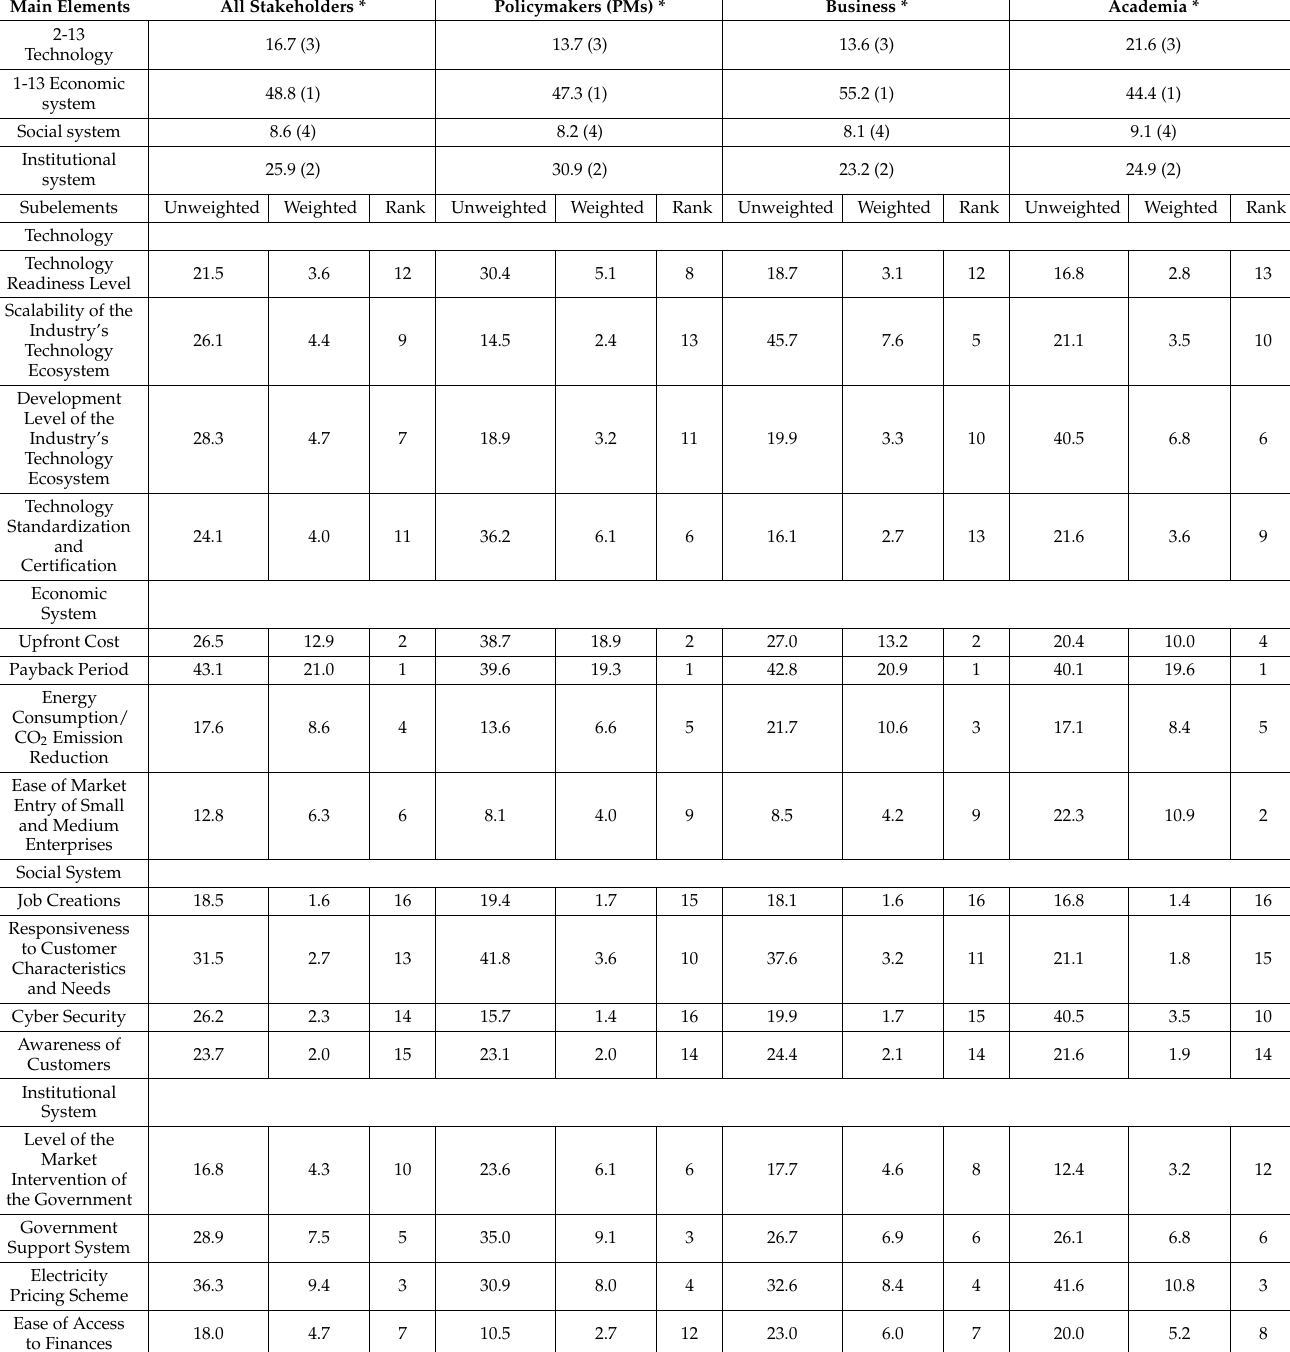
Table 3. Importance of each main and sub element by sector. (Unit: